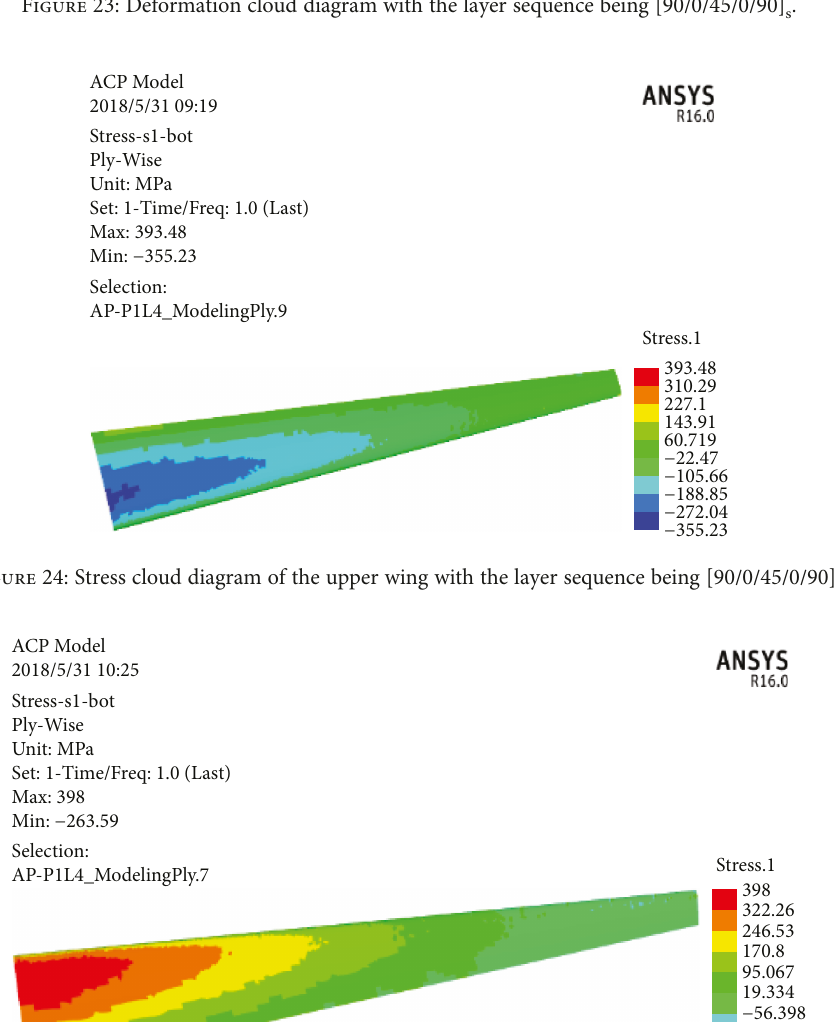
Figure 23: Deformation cloud diagram with the layer sequence being [90/0/45/0/90]